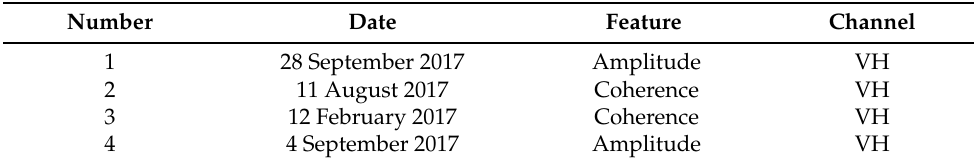
Table 3. First four selected features through the mutual information based